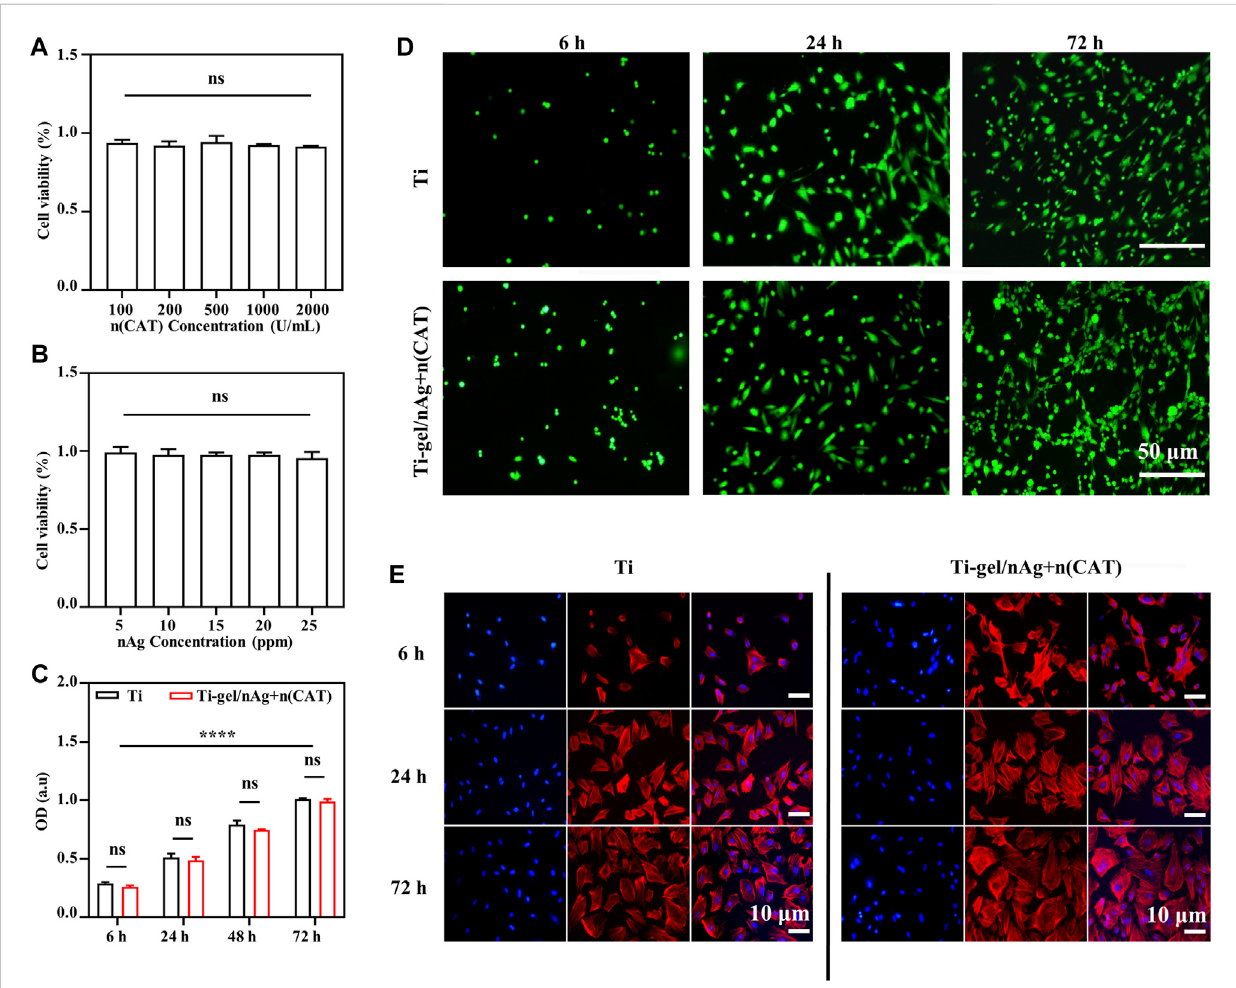
FIGURE 3 TheadhesionandcellproliferationofBMSCsonthesurfaceofTi-gel/nAg+n(CAT). (A,B) Cellviabilityatdifferentconcentrationsofn(CAT)andnAg. (C,D) BMSC fl uorescence images adhered to different surfaces at different time points, and BMSC proliferation pro fi les were obtained by the CCK-8 assay. (E) Cell morphology of BMSCs growth on different surfaces at different time points. (n = 3, ns means that there are no signi fi cant differences, **** p <